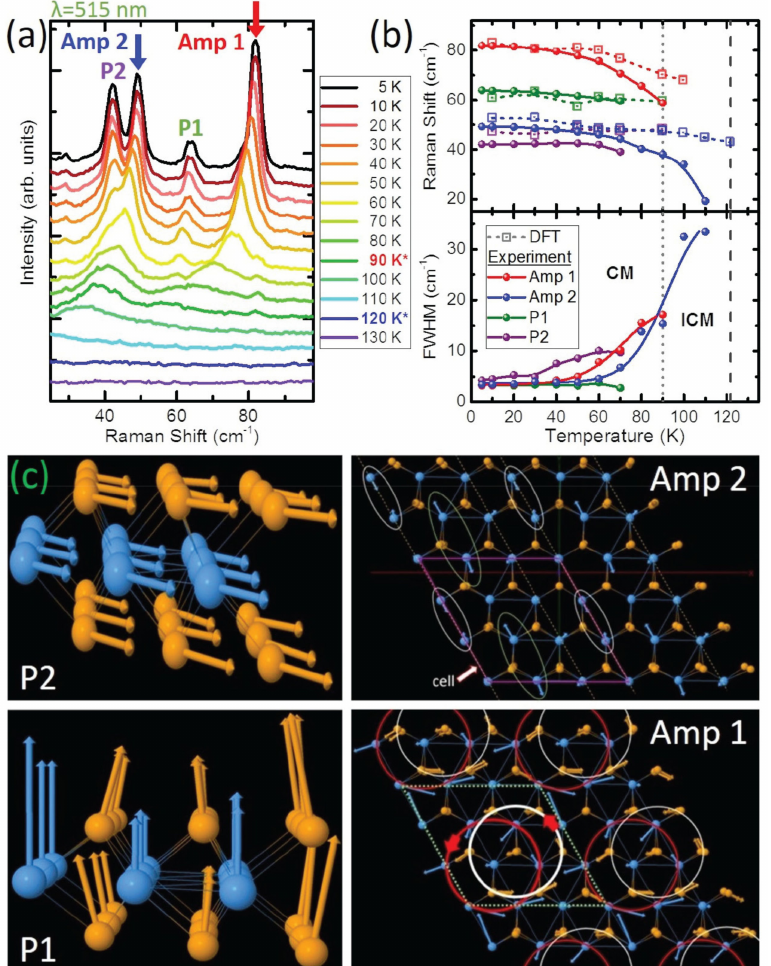
Figure 14. ( a ) Low-frequency Raman spectra show four modes emerge at low temperatures: Amp 1, Amp 2, P1, and P2. Amp 1 and Amp 2 are the CDW amplitude modes, whereas P1 and P2 are the phase modes. The transition temperature for the IC- (C-) phase is indicated in the legend by the blue (red) star. ( b ) Temperature dependence of the frequencies and full width at half maximum of Amp 1, Amp 2, P1, and P2. The DFT-calculated frequencies are plotted as a function of electronic temperature, using the same temperature axis. Solid lines guide the eye. The transition temperature for the IC-CDW (C-CDW) is indicated by a dark (light) gray dashed line. ( c ) DFT-calculated vibrations for the phase (side view) and amplitude (top view) modes. Reprinted figure with permission from Reference [108]. Copyright 2019 by the American Physical